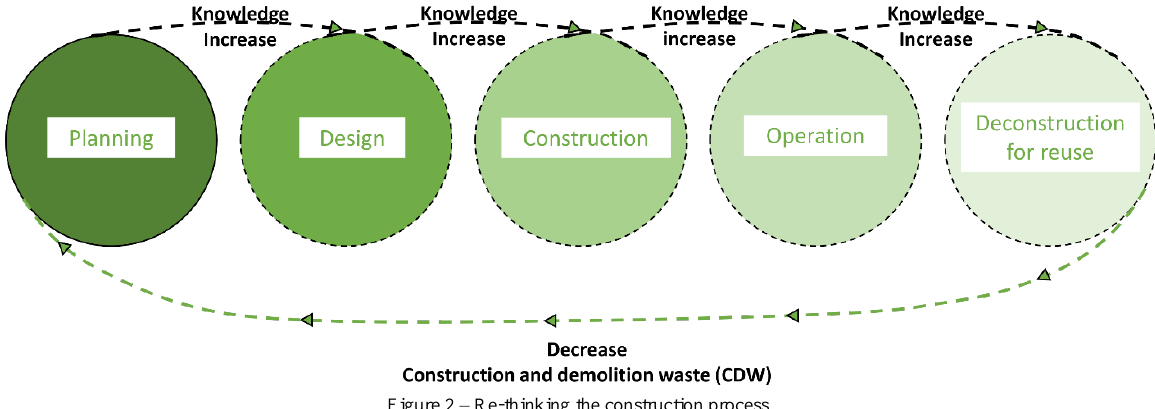
Figure 2 – Re-thinking the construction